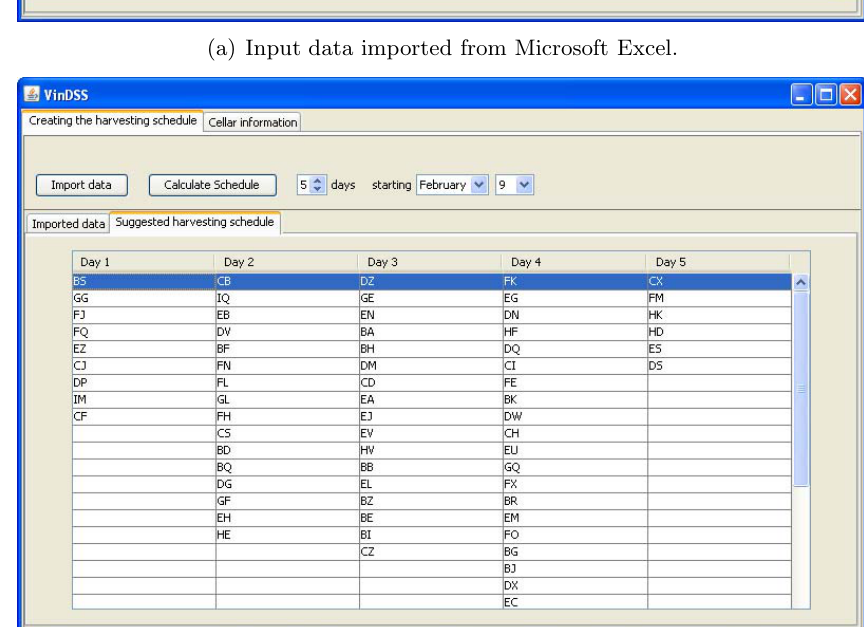
Figure 3: User interface screen shots of the decision support system, VinDSS